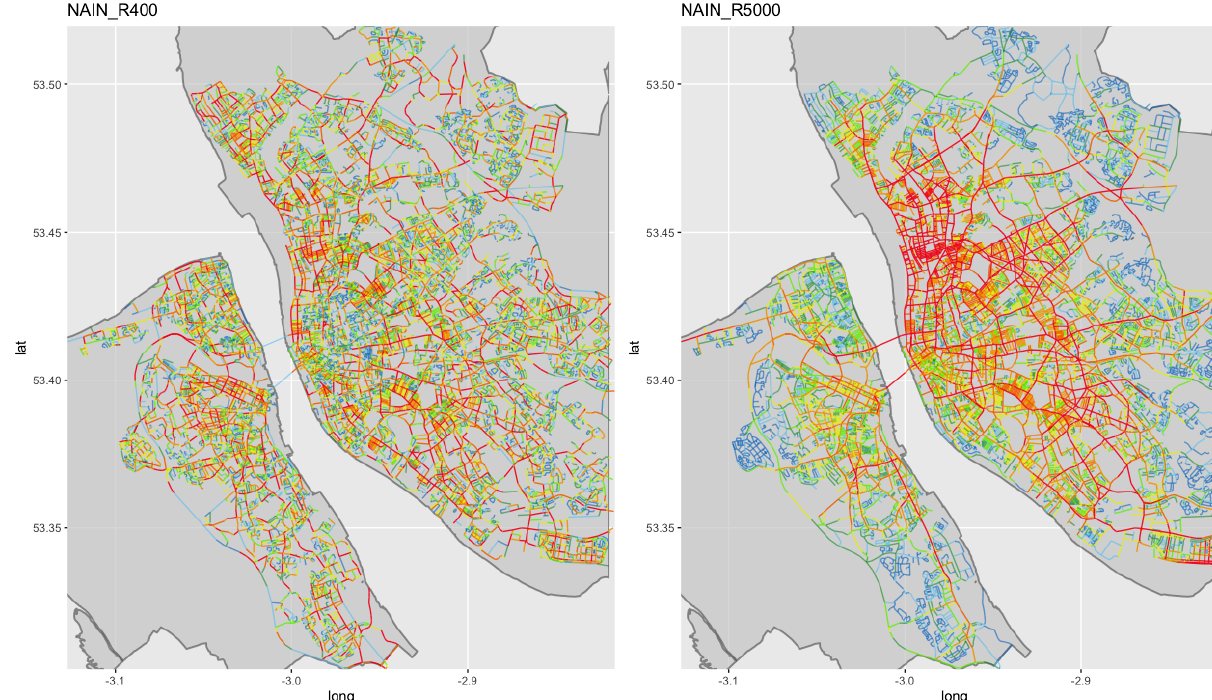
Figure 5. Urban Integration cores for the Liverpool, UK, conurbation. Left: local scale based on 400m; Right: global scale based on 5000m.